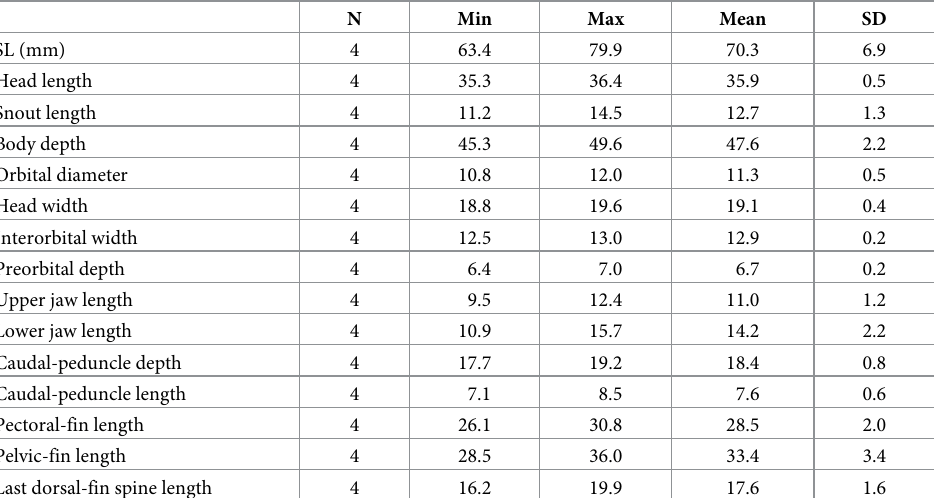
Table 14. Australoheros ribeirae . Size (SL) and proportional measurements (per cent of SL).